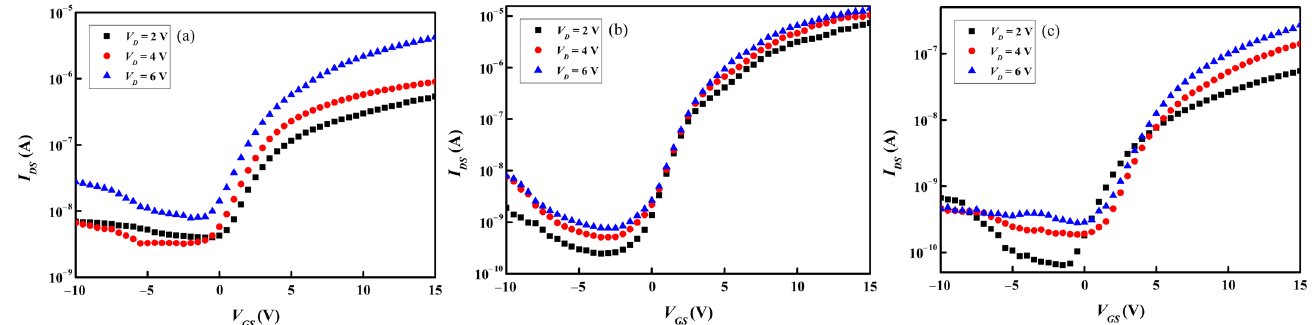
Figure 9. Transfer characteristics of TFT samples containing as-deposited ( a ) a -InGaZn 2 O 5 , ( b ) a - InGaZnO 4 , and ( c ) a -InGa 2 ZnO 5.5 active channel layers.